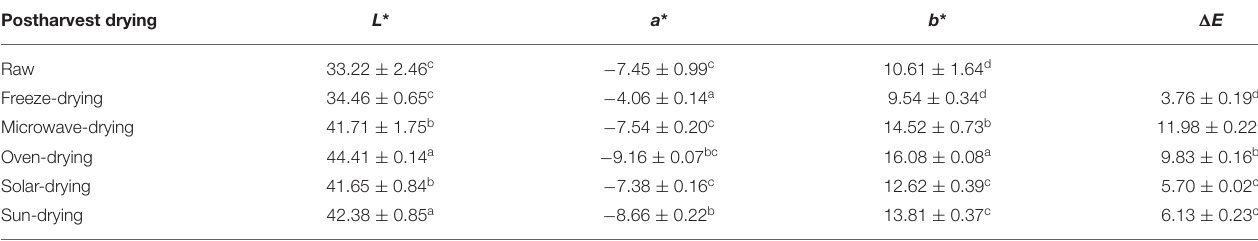
TABLE 1 | Effect of different drying treatments on color values and color change in the leaves var. Butternut squash ( C. moschata ). Postharvest